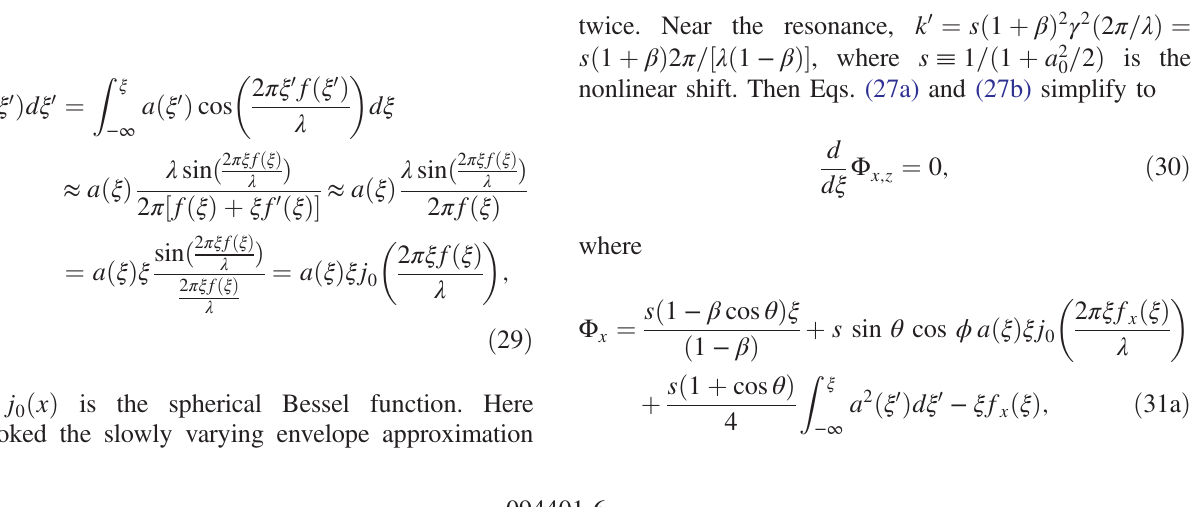
k Þ and x ð ξ Þ ¼ a − ξ 2 = ½ 2 ð ¯ σλ Þ 2 (cid:2)g 0 exp f G ð